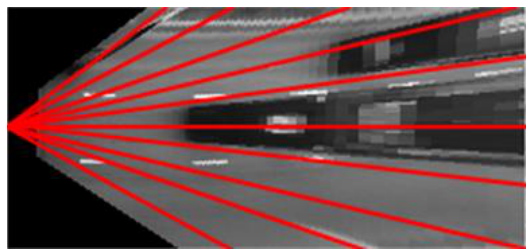
Figure 3. Scanning the Inverse Perspective Mapping (IPM) image with rays starting from the camera location.